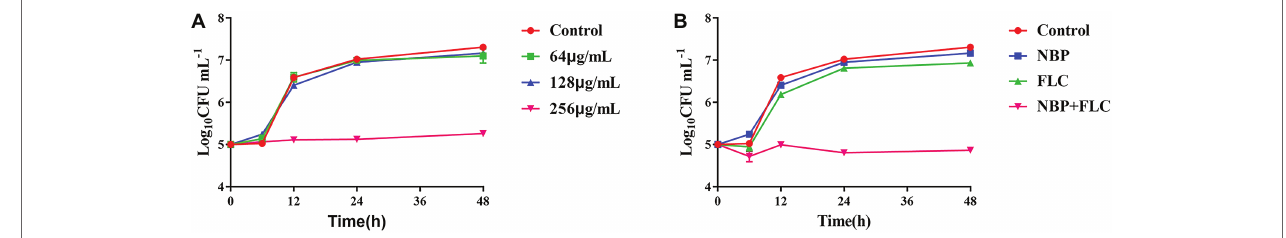
FIGURE 2 | Time-killing curves of NBP alone (A) and in combination with FLC (B) against C. albicans . The initial yeast concentrations were adjusted to 10 5 CFU/mL. (A) The concentrations of NBP were 64, 128, and 256 μg/ml, respectively. (B) The concentrations of NBP were 128 μg/ml when combined with FLC (1 μg/ml). Values represent the means ± standard deviation of three replicates.